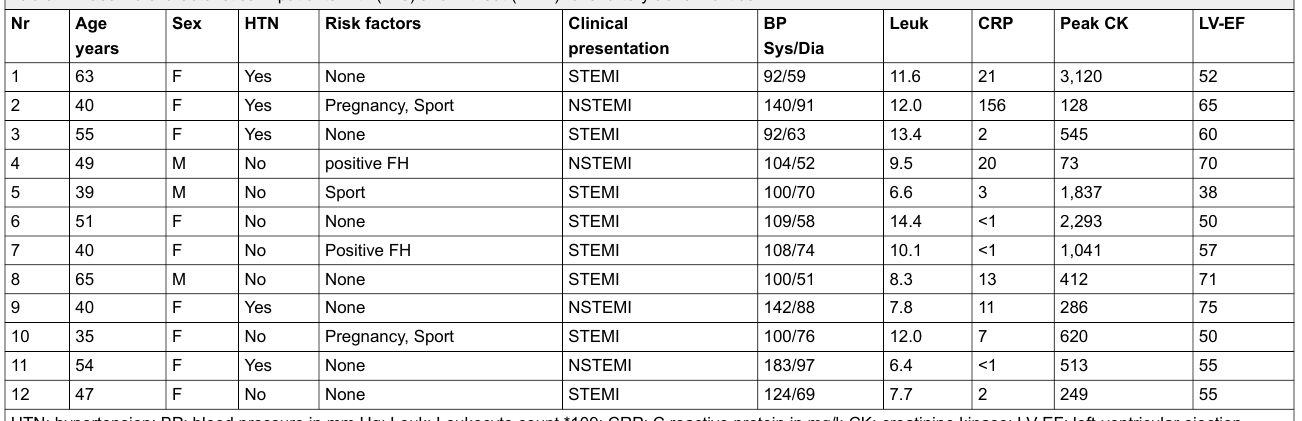
Table 1: Baseline characteristics in patients with (1–3) and without (4–12) renal artery abnormalities. Nr Age Sex HTN Risk factors years